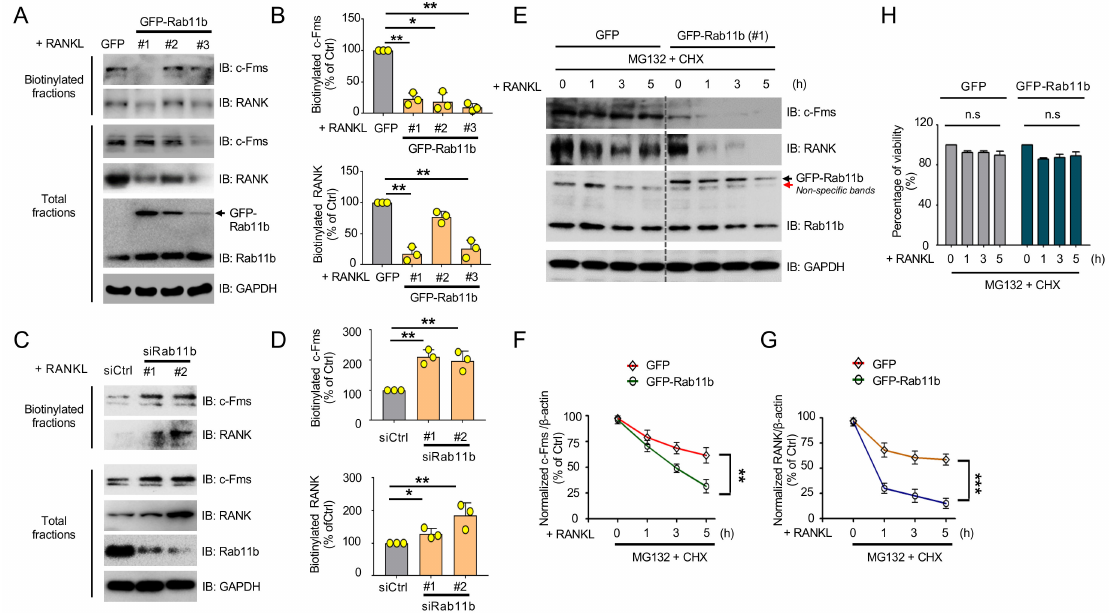
Figure 7. The e ff ects of Rab11b overexpression on lysosome-mediated proteolysis of c-Fms and RANK receptors in osteoclasts. ( A ) RAW-D cells expressing GFP or three di ff erent types of GFP-Rab11b (#1, #2, and #3) were stimulated with RANKL (300 ng / mL) for 3 days. The cells were fractionated into two separate fractions including biotinylated fraction and total fraction as the protocol indicated in the “Material and Methods” section. The surface and total levels of c-Fms and RANK were evaluated by biotinylation pulldown and immunoblotting, respectively. ( B ) The densitometry quantification of bands indicating surface expression of c-Fms and RANK receptors was shown in the presence of GFP-Rab11b as a percentage of control (GFP). Mean ± SD of three independent repeats; * p < 0.05, ** p < 0.01 (Student’s t -test). ( C ) RAW-D cells were transfected with scrambled siRNA (siCtrl) or one of two di ff erent Rab11b siRNAs (Rab11b siRNA #1, Rab11b siRNA #2), followed by RANKL (300 ng / mL) stimulation for 3 days. The cells were fractionated into two separate fractions including biotinylated fraction and total fraction as the above protocol. The surface and total levels of c-Fms and RANK were evaluated by biotinylation pulldown and immunoblotting, respectively. ( D ) The densitometry quantification of bands indicating surface expression of c-Fms and RANK receptors was shown in the presence of Rab11b siRNAs as a percentage of control (siCtrl). Mean ± SD of three independent repeats; * p < 0.05, ** p < 0.01 (Student’s t -test). ( E ) RAW-D cells expressing GFP or GFP-Rab11b (#1) were stimulated with RANKL (300 ng / mL) for 3 days, followed by treatment with a combination of MG132 (20 µ M) and CHX (20 µ g / mL) for 0, 1, 3, and 5 h. Total levels of c-Fms and RANK were evaluated by immunoblotting. ( F , G ) The densitometry quantification of bands indicating total expression of c-Fms ( F ) and RANK ( G ) was shown as a percentage of the 1st lane for the GFP group referred to as the control (Ctrl), and the 5th lane for the GFP-Rab11b group referred to as the control (Ctrl). Mean ± SD of three independent repeats. ** p < 0.01, *** p < 0.001 (Student’s t -test). ( H ) Cell viability was assessed by the cellular ATP content measurement using the Cell Titer Glo Assay system. After stimulated with RANKL (300 ng / mL) for 3 days, RAW-D cells were co-treated with CHX (20 µ g / mL) and CLQ (10 µ M) over a time course. The values were the average of triplicate determinations with SD indicated by error bars. n.s., nonsignificant (Student’s t -test). The experiments were repeated